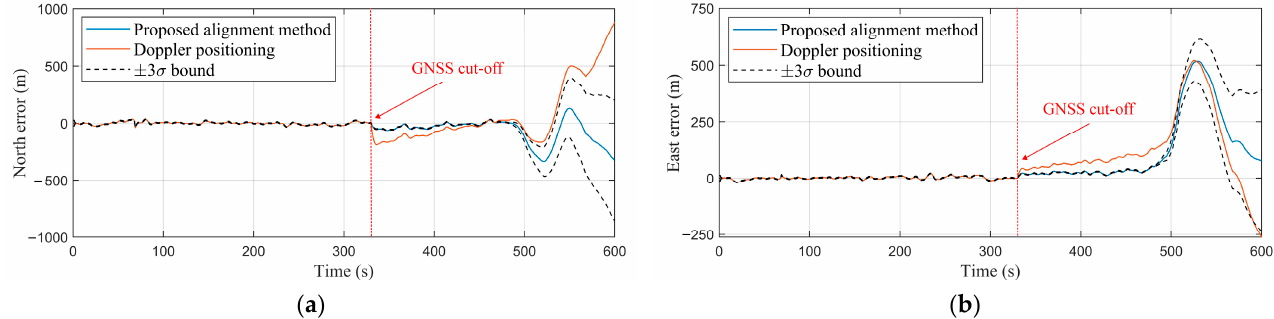
Figure 15. Experimental results include the geographical view of the airport and a comparison of the true and estimated trajectory.